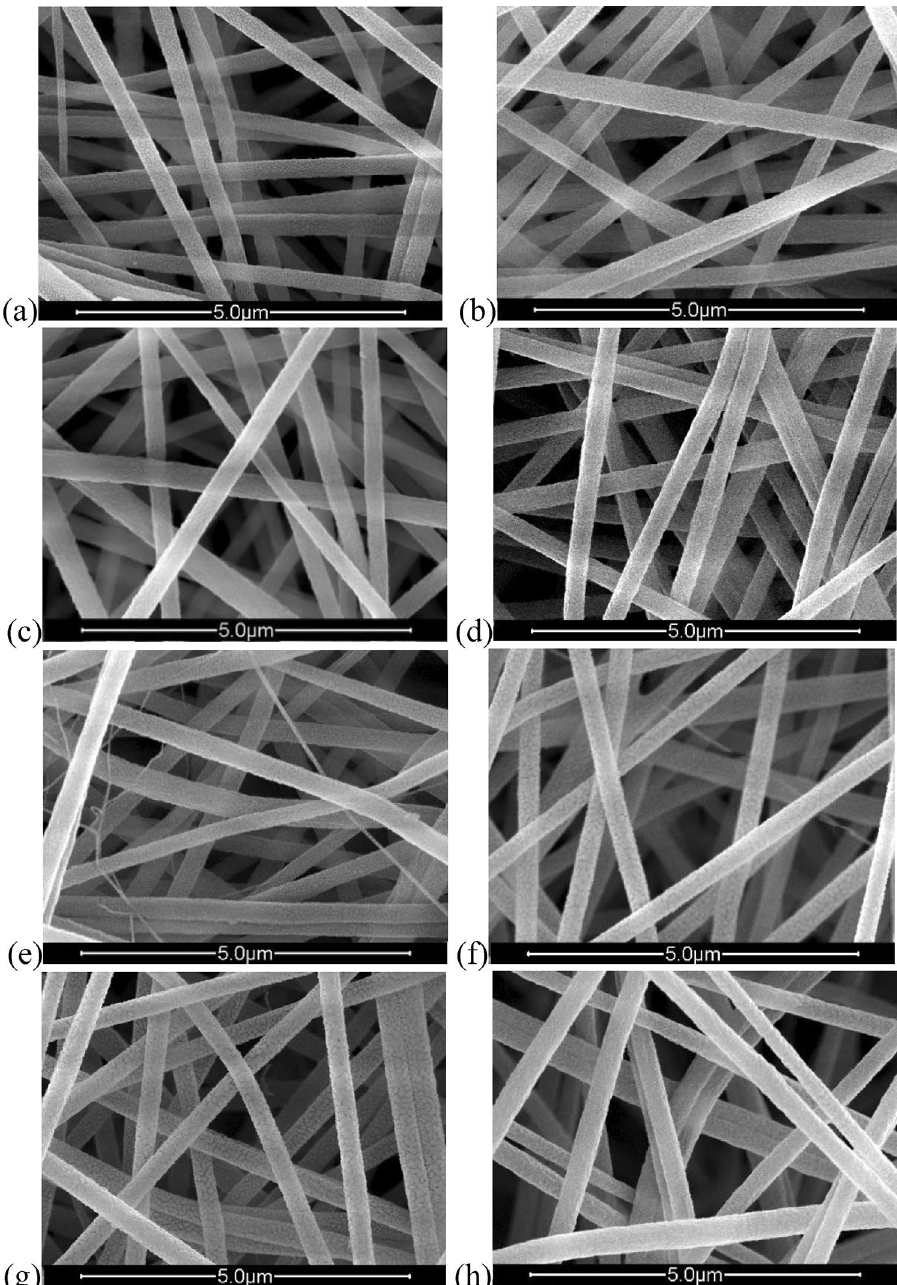
Figure 2. SEM images of ( a ) neat PAN; ( b ) PAN-25PCM28; ( c ) PAN-50PCM28; ( d ) PAN-25PCM32; ( e ) PAN- 50PCM32; ( f ) PAN-12.5PCM28-12.5PCM32; ( g ) PAN-25PCM28-25PCM32; ( h )